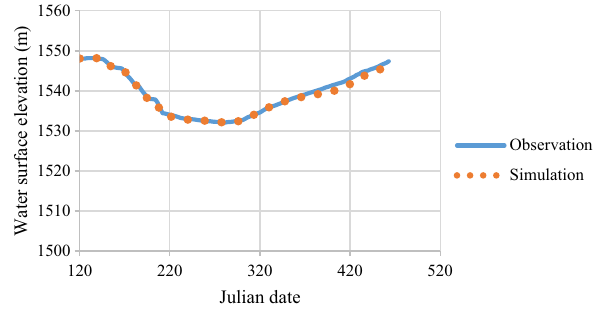
Fig. 7 The observed and simulated water surface elevation of the Yamchi dam reservoir Table 2 Calculated errors for the simulation of water surface eleva-